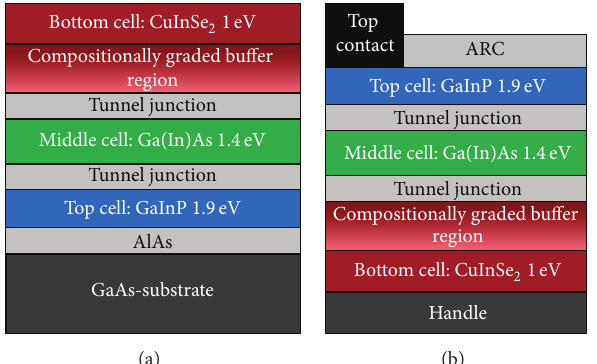
Figure 1: Proposed (a) growth sequence and (b) final design of the inverted metamorphic GaInP/Ga(In)As/CuInSe 2 structure after a selective wet etch of an AlAs release layer.